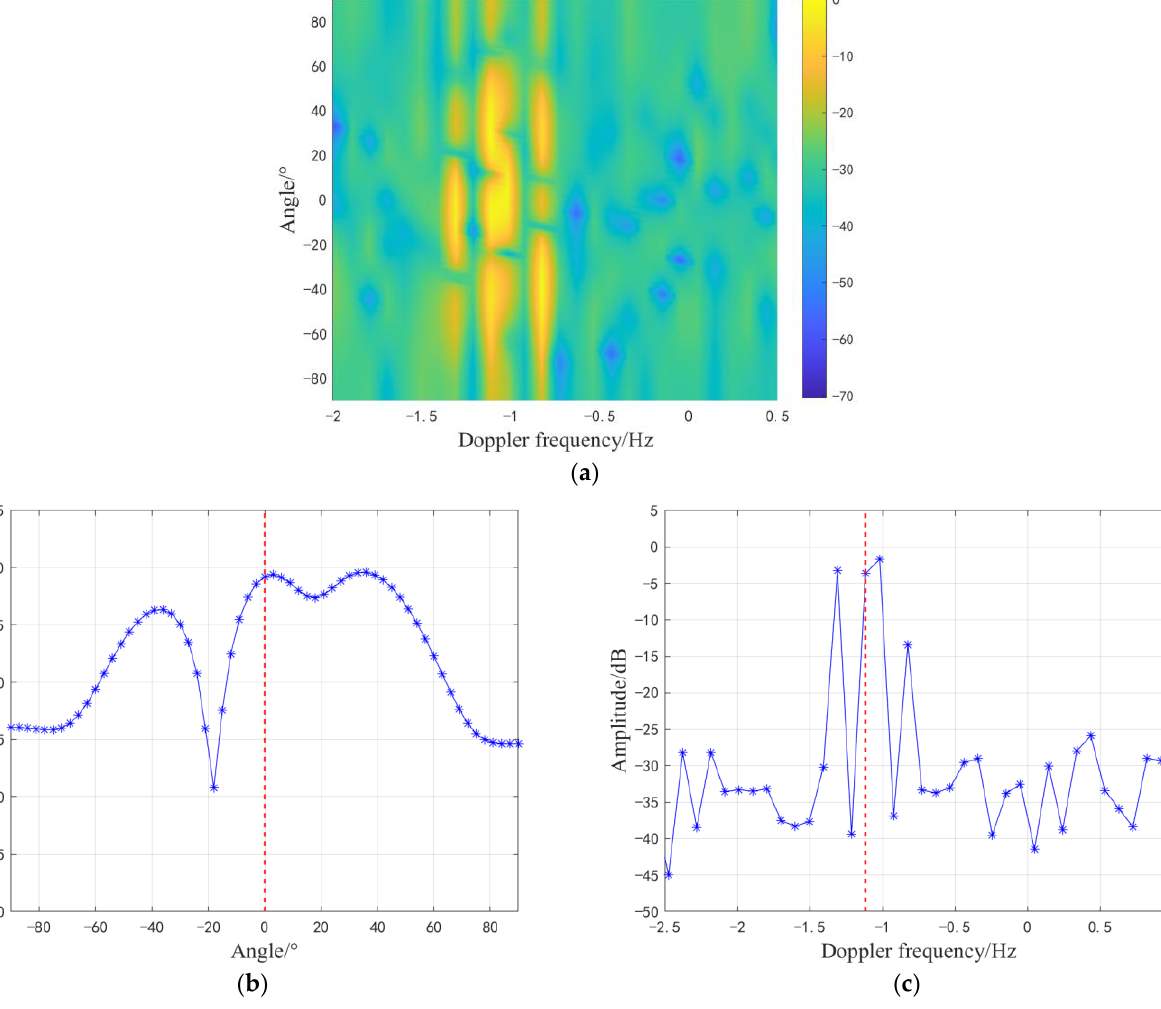
Figure 2. ( a ) Angle–Doppler map of simulation data; ( b ) angle domain curve at the target Doppler frequency; and ( c ) Doppler frequency curve in the target angle.